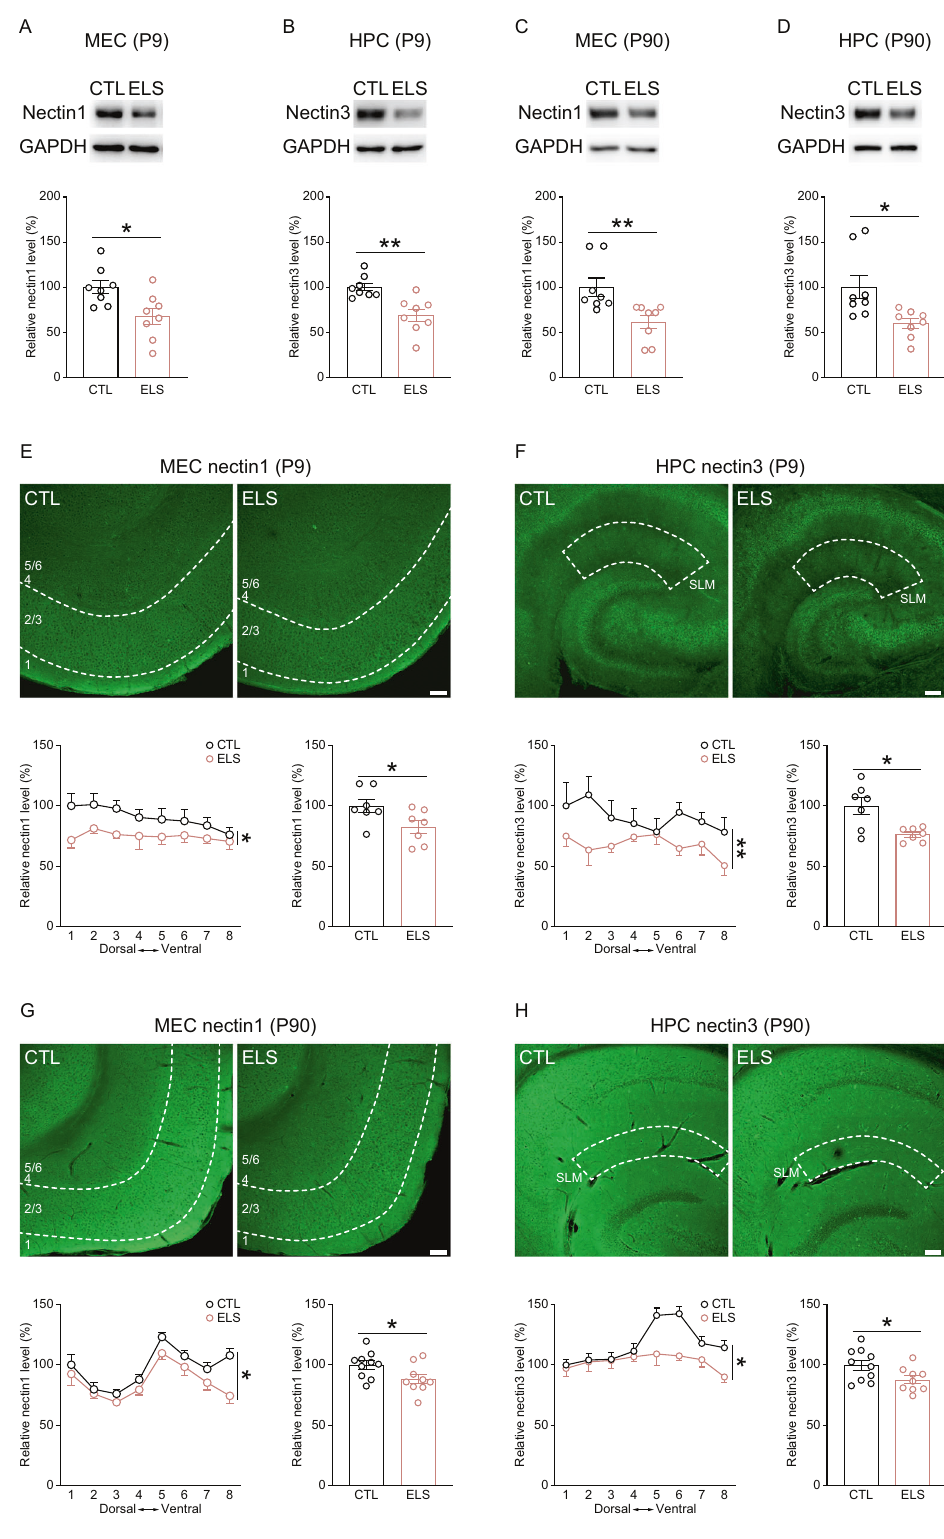
gels and transferred onto polyvinylidene di fl uoride membranes (Millipore, Bedford, MA, USA). Membranes were then labeled with primary rabbit anti- nectin1 (1:2000, Santa Cruz), rabbit anti-nectin3 (1:2000, Abcam), mouse anti-actin (1:10,000, E021020-01, EarthOx, Millbrae, CA, USA), mouse anti-